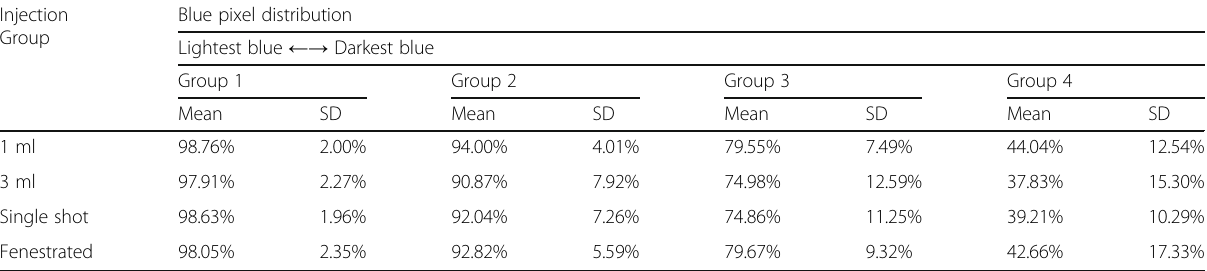
Table 1 Mean percentage +/ − Standard deviation (SD) of the Blue pixels distributed within the CET tendon from lightest blue to darkest blue in four groups of blue colour graduation (lightest blue = group 1, darkest blue = group 4)) Injection Blue pixel distribution Group Lightest blue ←→ Darkest